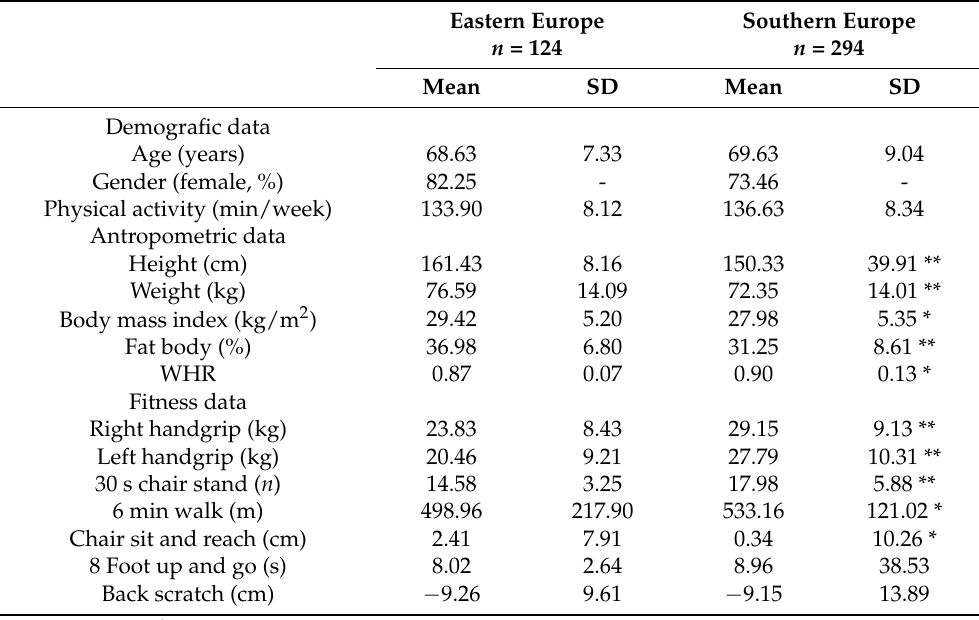
Table 1. Comparative analysis of demographic, anthropometric and fitness measures of residence in eastern Europe and southern